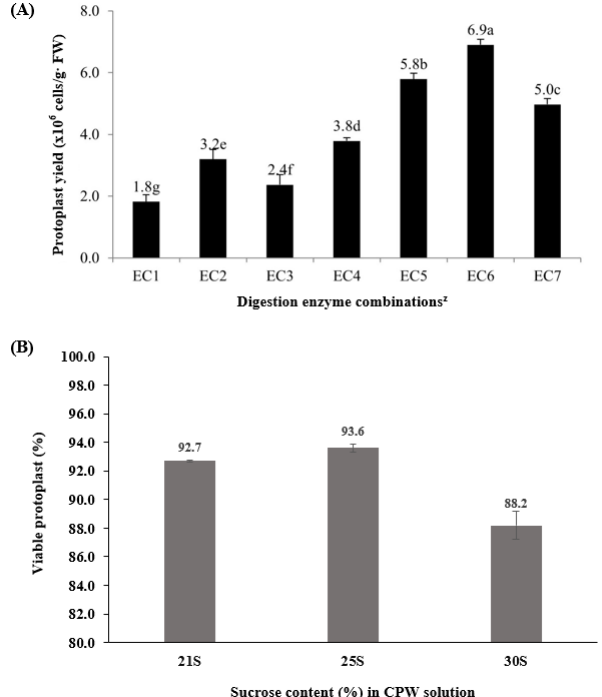
Figure 1. The calculated protoplast yield after enzyme digestion ( A ) and sucrose purification ( B ). The percentage of viable protoplasts was calculated by counting the green-dyed cells after reaction in the 0.01% FDA solution. Error bars indicate standard errors of the means and different letters indicate significant differences at p ≤ 0.05 according to Duncan’s multiple range test (DMRT). z Treatments with digestion enzymes comprised seven groups of enzyme combinations (EC). EC 1: 1.0% Cellulase R-10 TM (CR) + 0.2% Macerozyme R-10 TM (MR); EC 2: 1.5% CR + 0.5% MR; EC 3: 2.0% CR + 0.8% MR; EC 4: 0.2% Celluclast TM (Ce) + 0.2% Pectinex TM (PE) + 0.4% Viscozyme TM (Vz); EC 5: 0.4% Ce + 0.4% PE + 0.8% Vz; EC 6: 0.6% Ce + 0.6% PE + 1.2% Vz; EC 7: 0.8% Ce + 0.8% PE + 1.6% Vz.